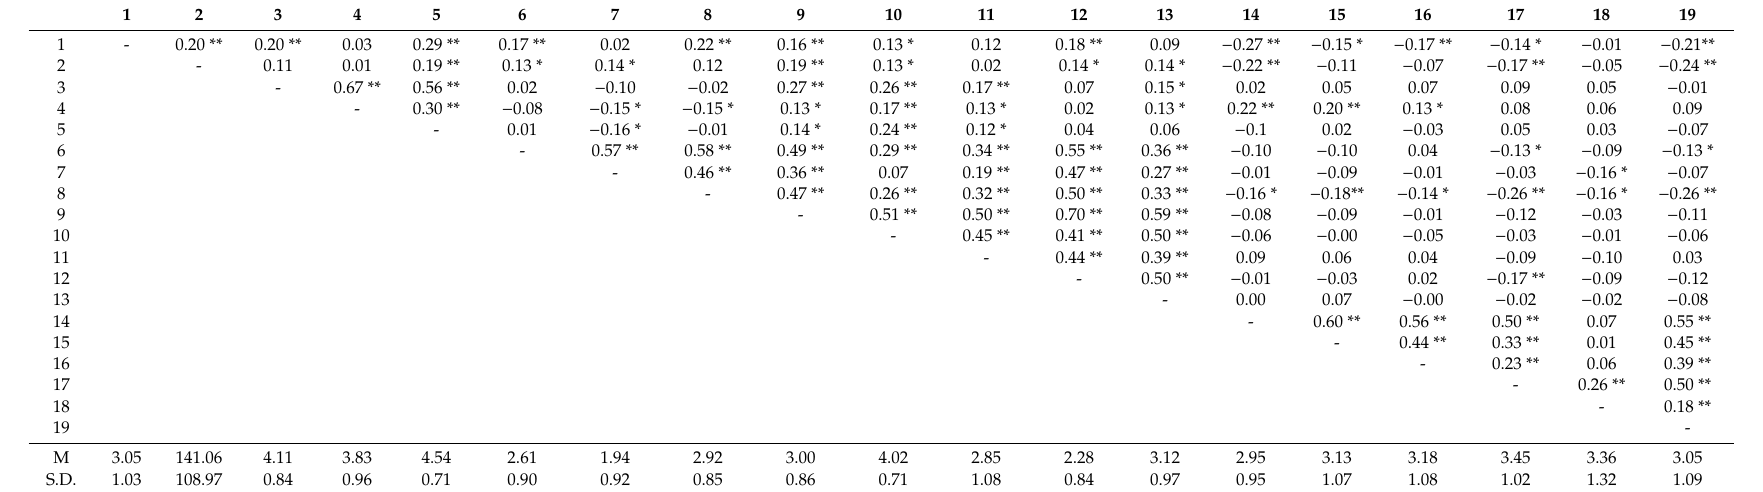
Table 3. The correlation and distributions of measured